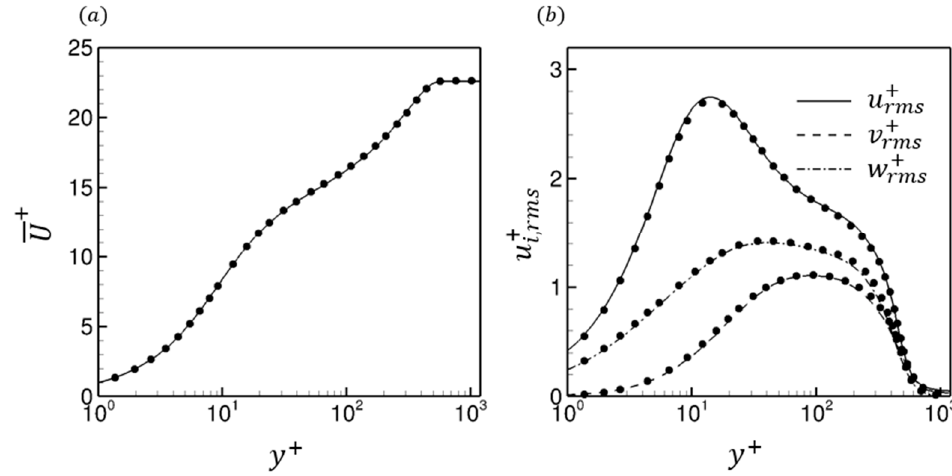
Figure 2. Inner-scaled ( a ) mean velocity and ( b ) RMS velocity fluctuations for the reference case S at Re θ = 1410. Lines: present results; symbols: data by Schlatter and Örlü (2010)